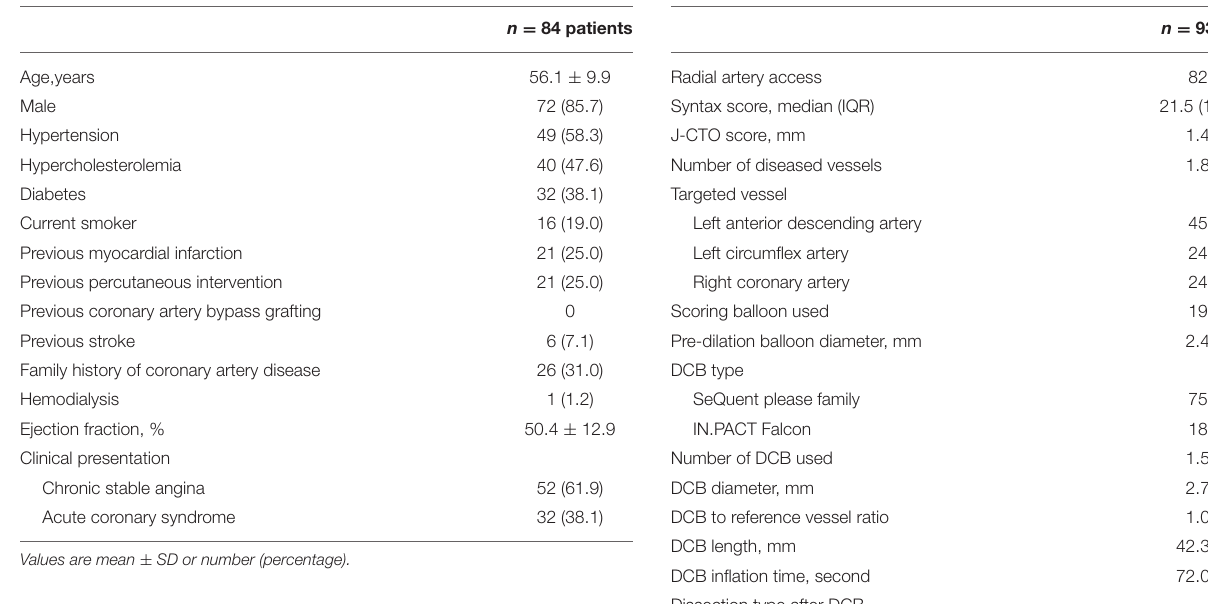
TABLE 1 | Baseline patient characteristics. TABLE 2 | Angiographic and procedural characteristics.